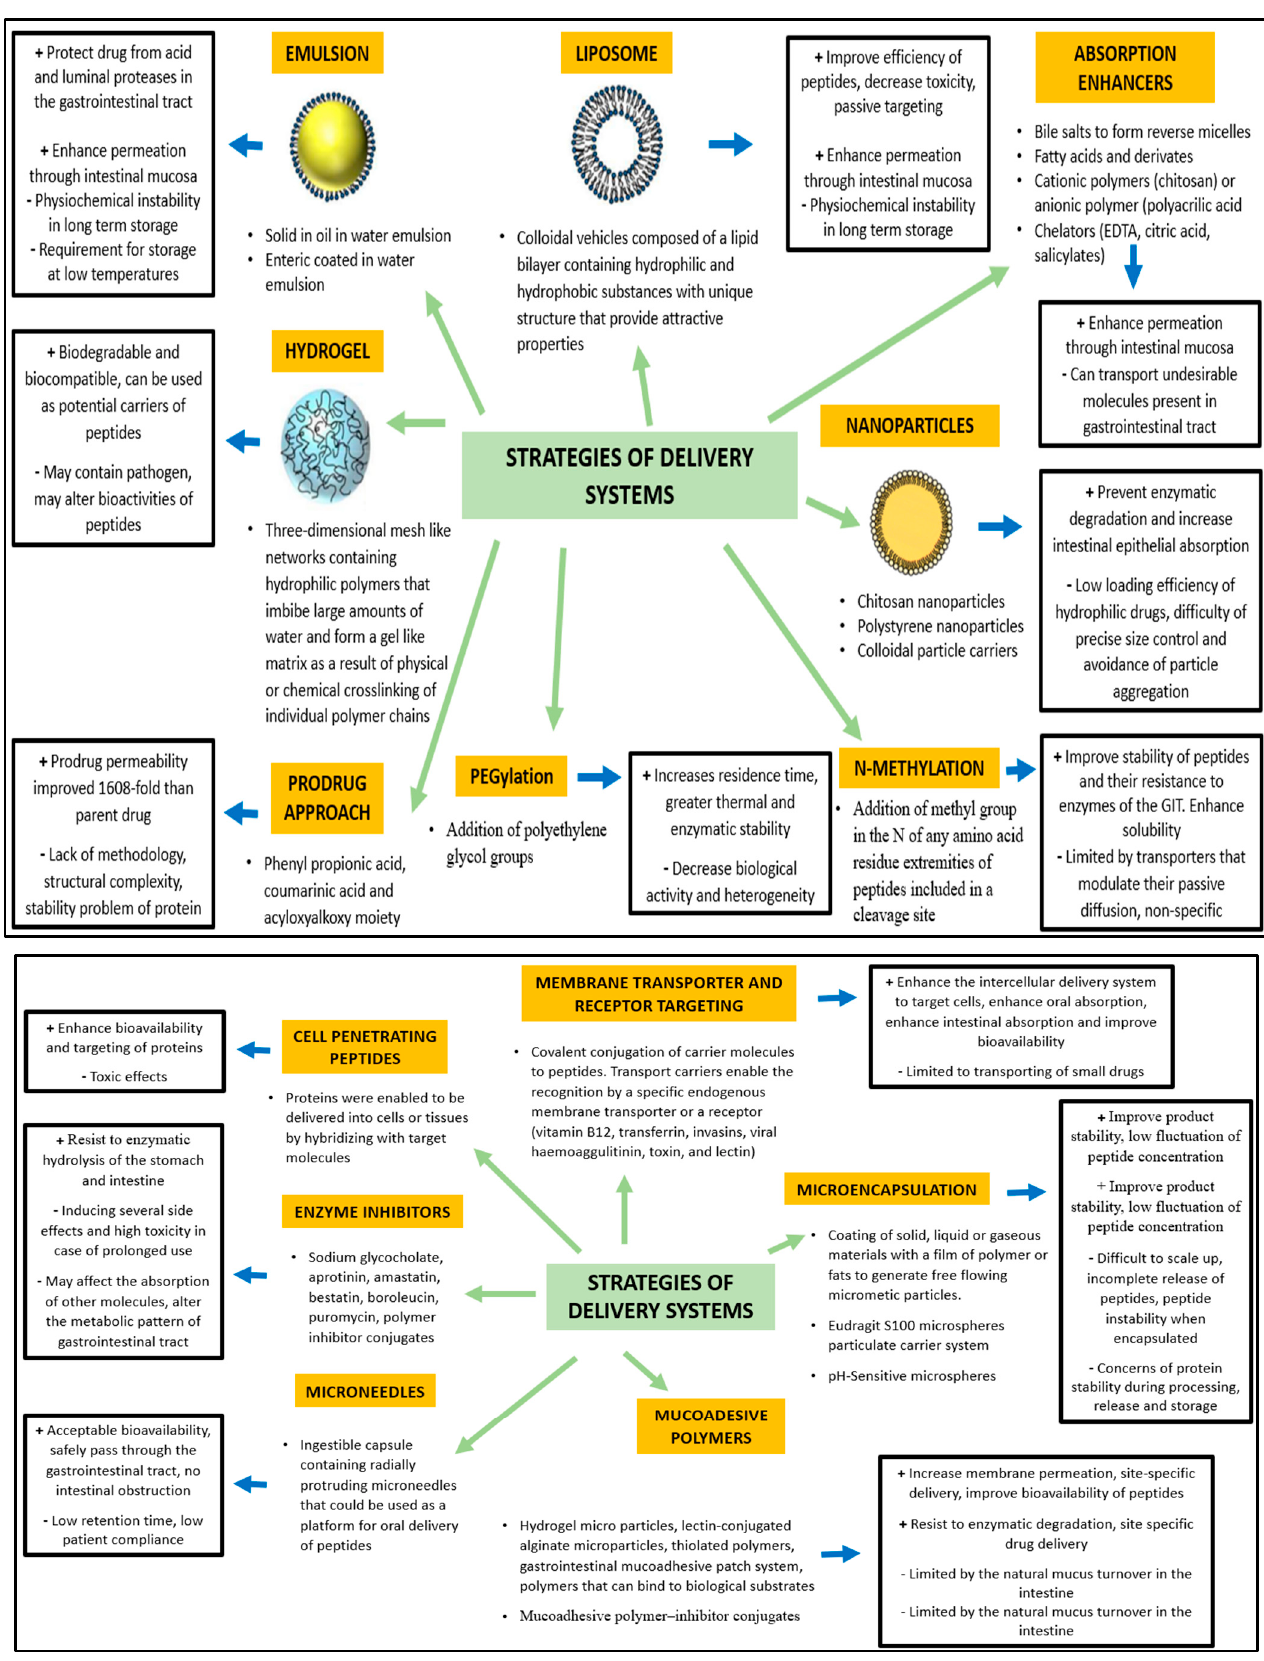
Figure 2. Strategies of delivery systems for bioactive peptides (Modified from Bechaux et al. 2019 [44]).